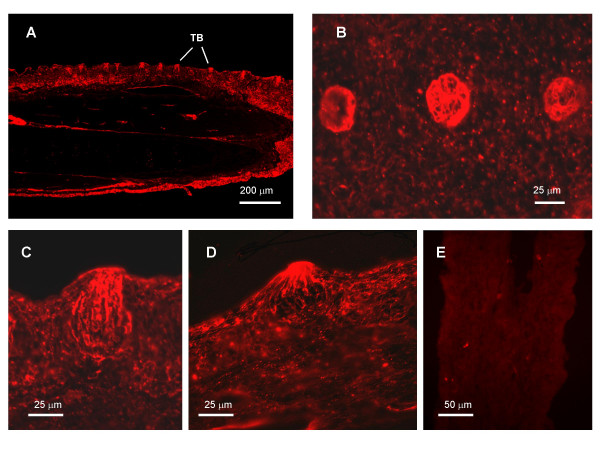
Immunohistochemistry of catfish barbel taste buds using antibodies GP1 and GP2. Barbels were fixed in 4% PFA, PBS, and cryostat sectioned at 10 microns. Sections were probed using indicated dilutions of antibodies GP1 and GP2. (A). Section through a barbel immuno-stained with GP1 at 1/8000 dilution. The lines from "TB" point to labelled taste buds. (B). The apical aspects of three taste buds immuno-stained with 1/12000 dilution of GP2. (C). Cross section through a taste bud immuno-stained with 1/16000 dilution of GP1. (D). A single taste bud immuno-stained with 1/8000 dilution of GP2. (E). Second antibody control showing barbel without exposure to primary antibodies.